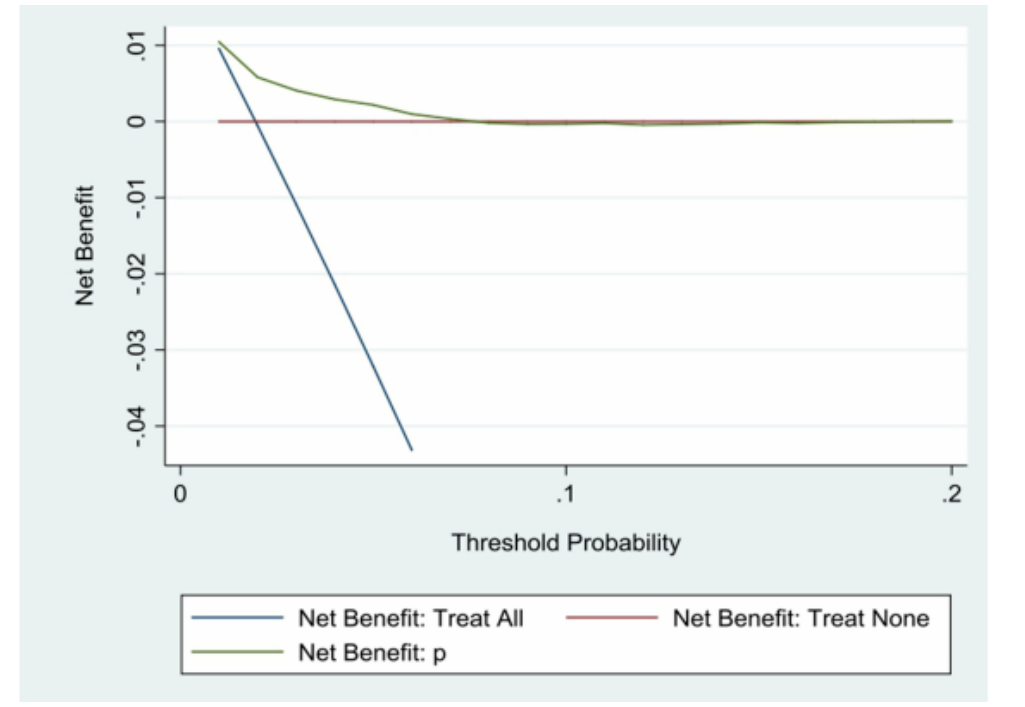
Figure 6. Decision curve analysis of the validation data